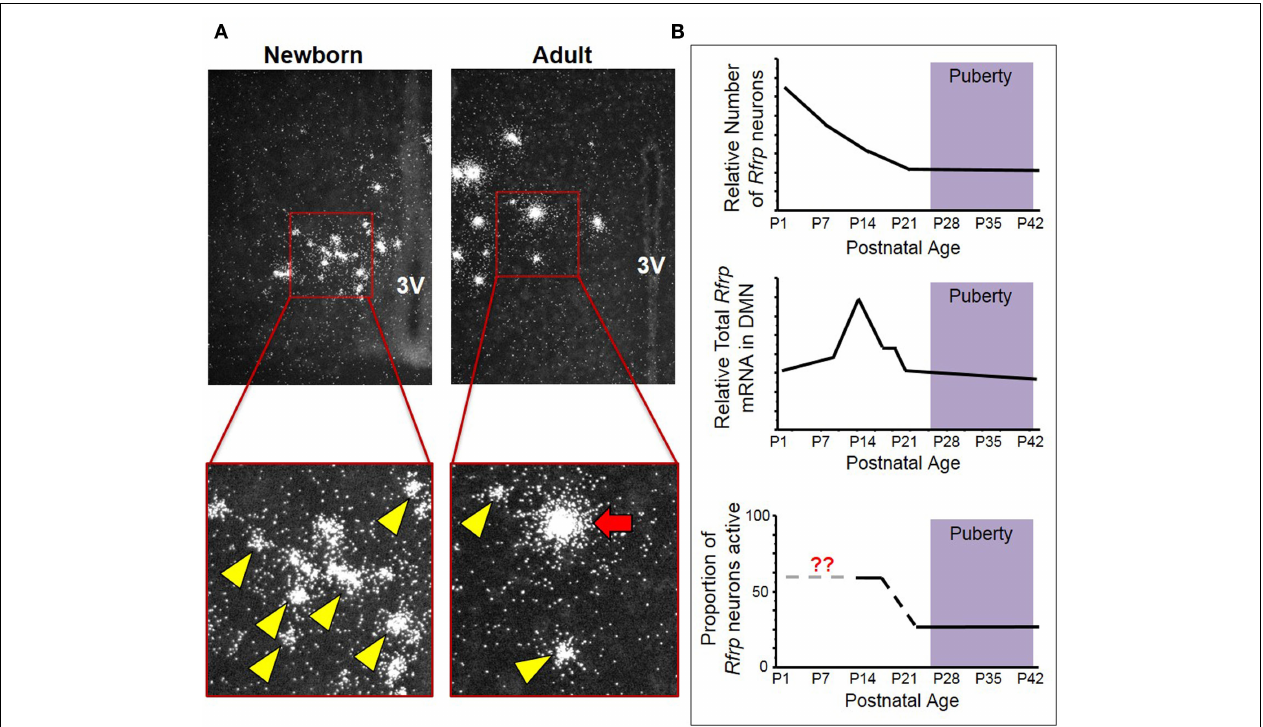
FIGURE 1 | Changes in neural Rfrp expression during postnatal development in mice . (A) Between the day of birth and adulthood, there are significant changes in the expression of certain subtypes of Rfrp neurons (categorized based on their Rfrp expression levels). Low-expressing (LE) Rfrp cells (yellow arrowheads) are the predominate subtype at birth whereas high-expressing (HE) Rfrp cells (red arrows) are first detectable during the 2nd week of postnatal life and remain present through adulthood. (B) Three graphic representations of Rfrp cell number, total Rfrp expression levels in the brain, and Rfrp neuronal activation (measured by c-Fos co-expression) during rodent postnatal development. P = postnatal day. The purple shading represents the approximate ages when puberty occurs.